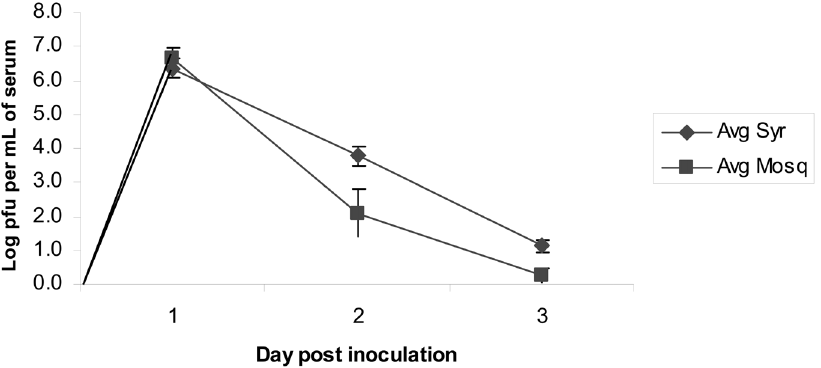
Figure 2. Mean daily titers ( + / 2 SE) of HJV in house sparrows determined by syringe-drawn blood or individual mosquito blood